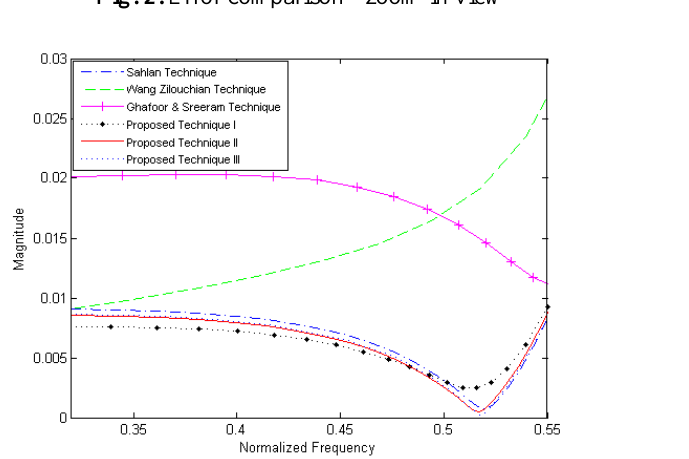
Fig. 2. Error comparison - zoom-in view